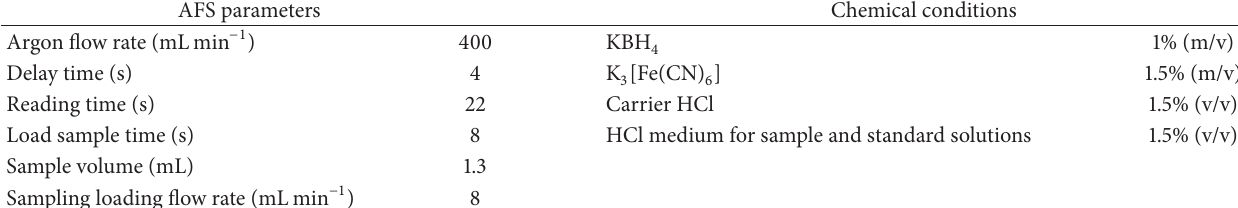
Table 1: Operation parameters of AFS instrument and FIA system.